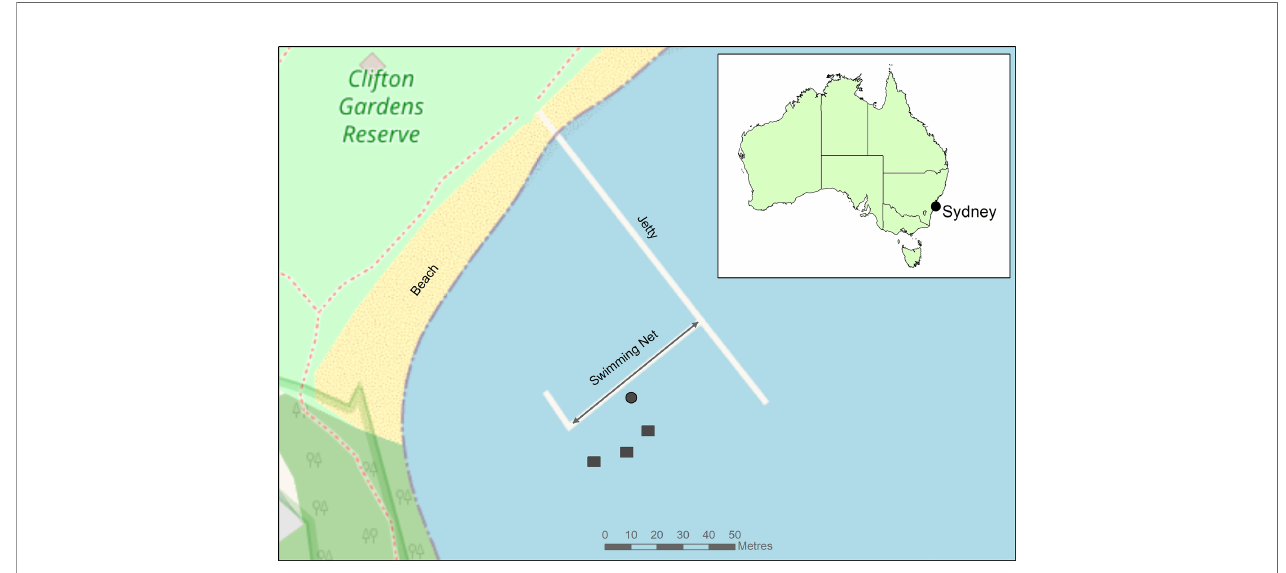
FIGURE 1 | Location of the protective swimming net at Clifton Gardens in Sydney, New South Wales, Australia and the location of the installed seahorse hotels. ● = release location for seahorses on swimming net and █ = Three seahorse hotels with each of the three designs (9 in total). The area indicated by the arrowed line is the survey area on the net for the monthly surveys of the captive-bred seahorses.